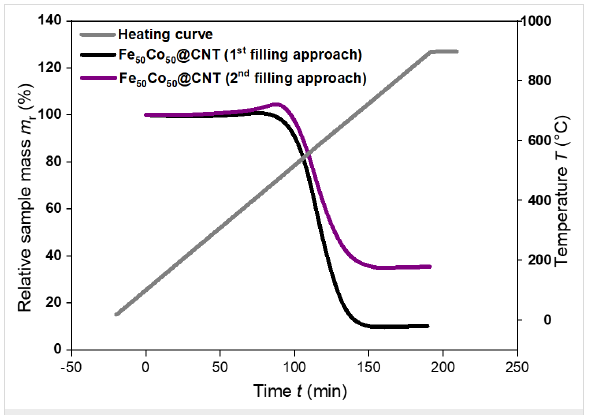
Figure 6: Relative sample mass loss for a sample prepared by the first (i.e., solution) approach (black) and the other by the second approach (purple) of Fe 50 Co 50 @CNT during the combustion process of the nanocomposite in which the CNT mass start to decrease at T ≈ 530